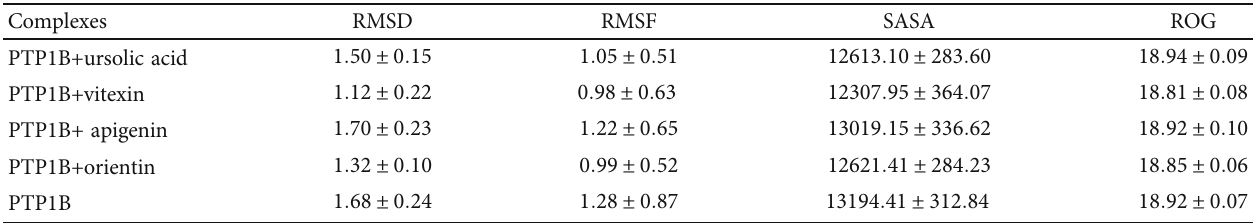
Table 3: Average (Å) postdynamic data of complexations of fl avonoid C-glycosides and apoenzyme. Complexes RMSD RMSF SASA ROG PTP1B+ursolic